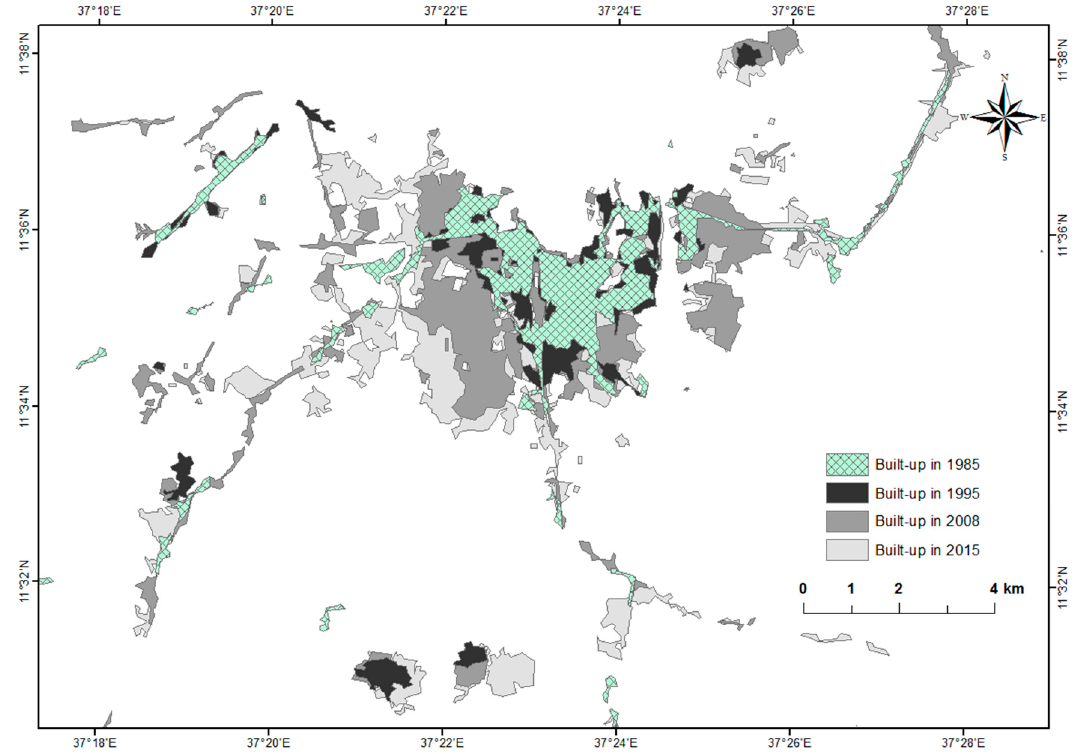
Figure 5. Horizontal expansion of Bahir Dar between 1985 and 2015.